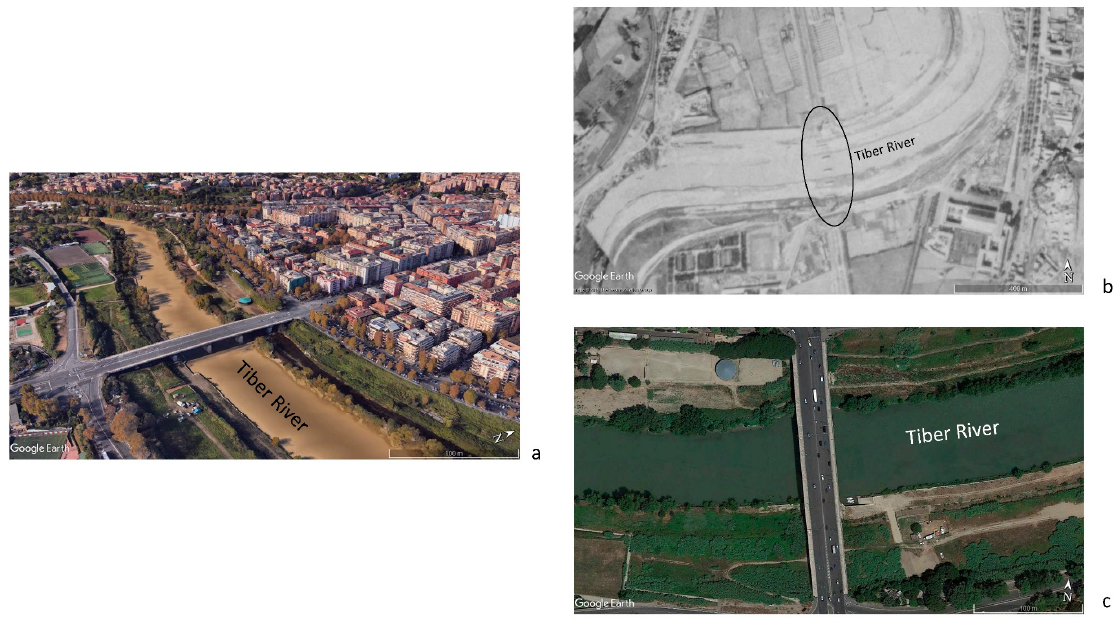
Figure 4. The Marconi Bridge on the River Tiber within the urban context of Rome ( a,c ); ( b ) The beginning of its construction after WWII (source: Google Earth).